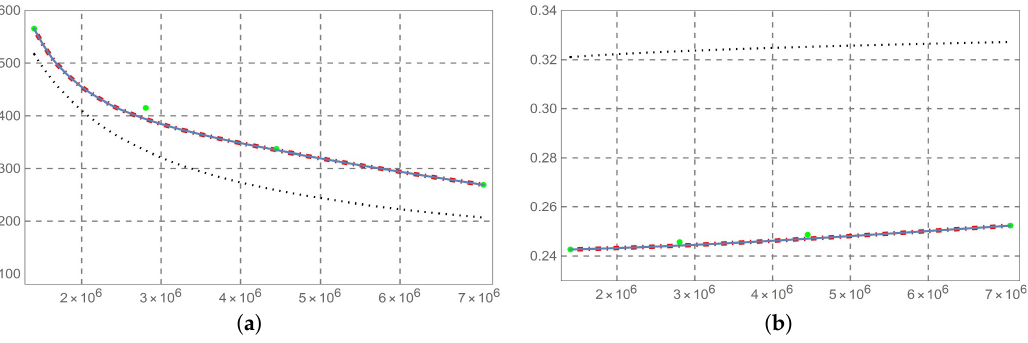
Figure 5. ( a ) Permittivity and ( b ) conductivity at frequencies 224 KHz @ 1 MHz. Line dot-dashed fractional model α = 1, line continue ordinary model, line dotted extensive Cole–Cole’s model, points experimental data.